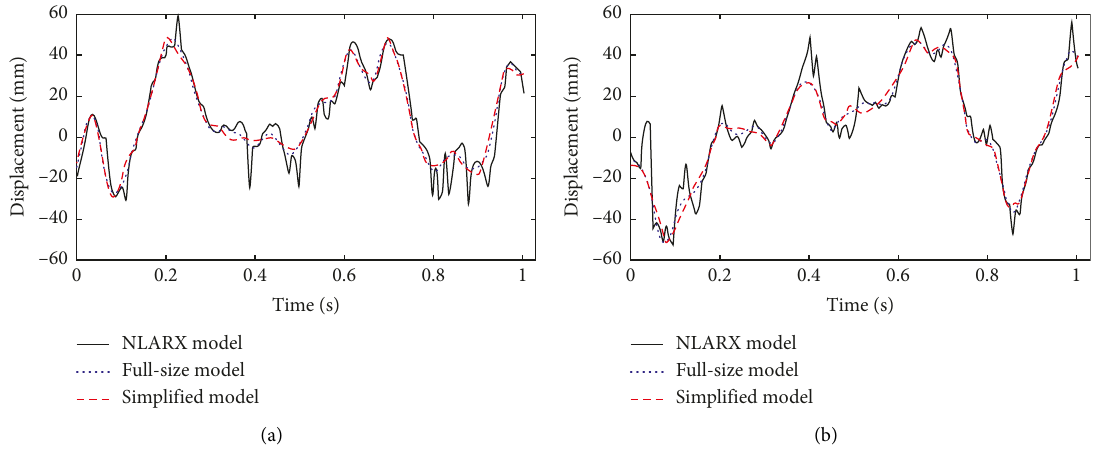
Figure 11: Vertical displacement histories: (a) at the left spring seats; (b) at the left spring